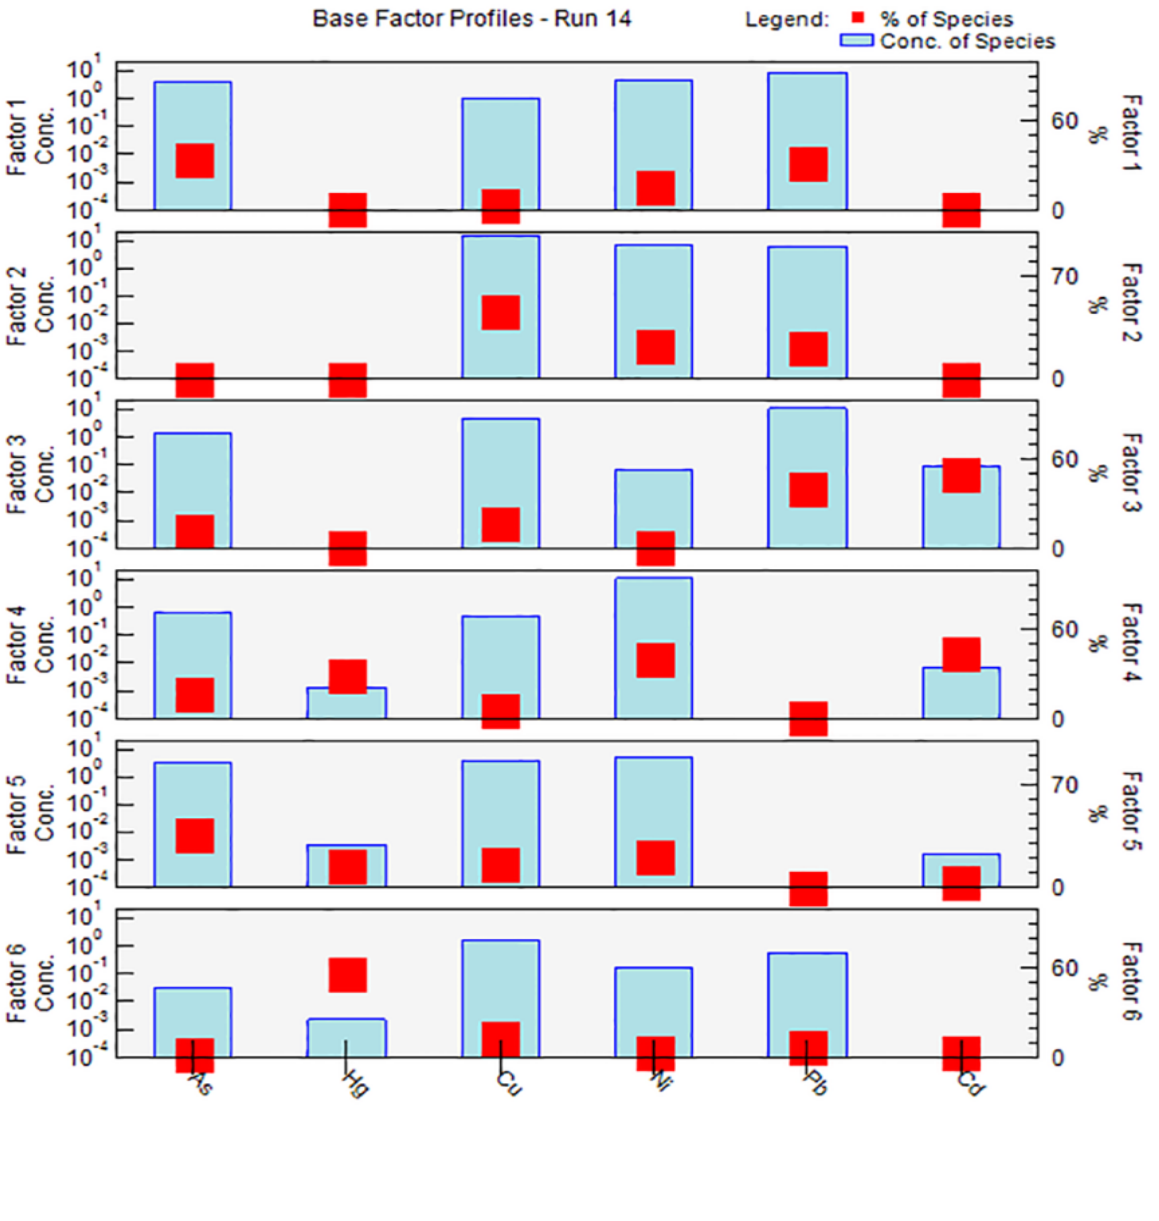
Figure 7: Contribution of various factors in the soil pollution of